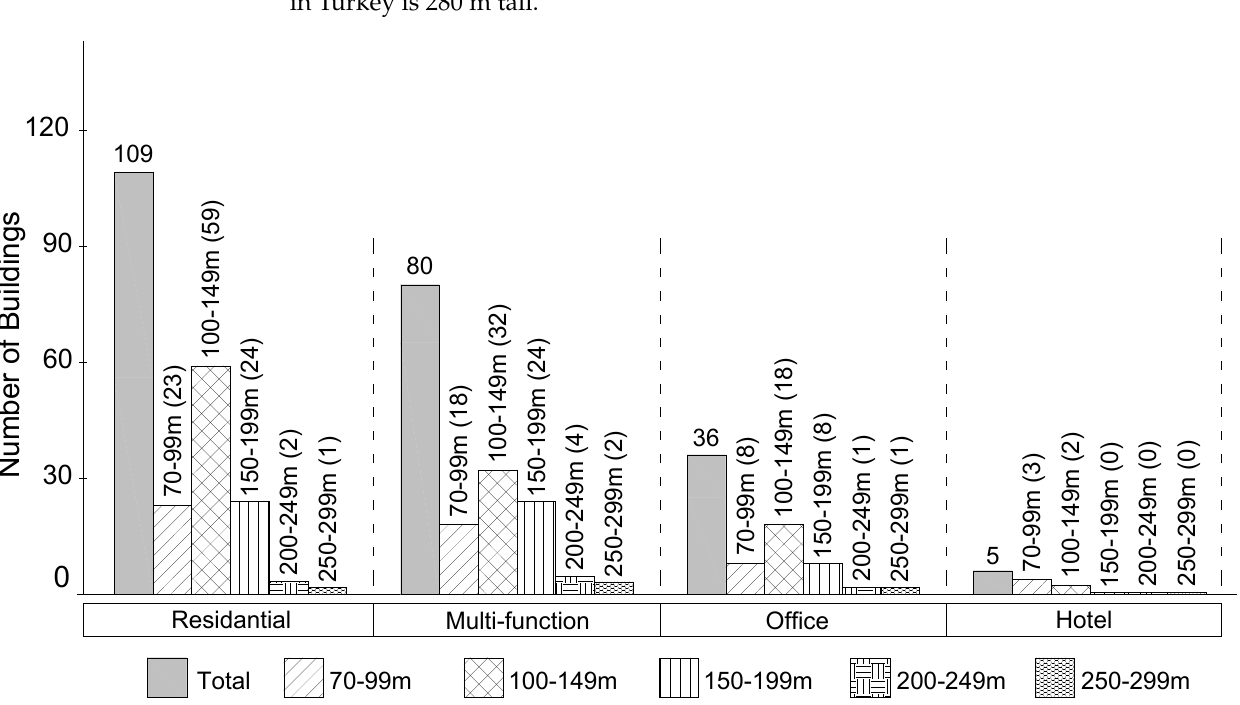
Figure 19. Relation between building height and building function.